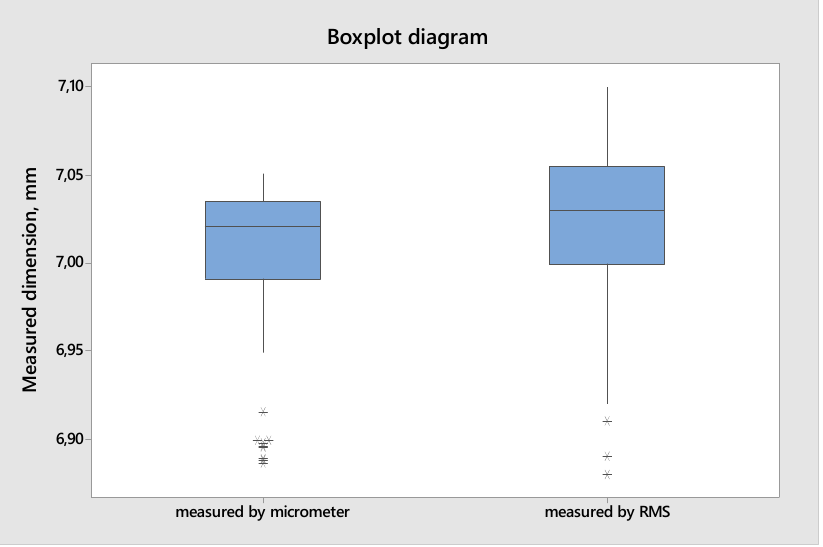
Figure 12. Measured values are shown on boxplot diagram for comparison.